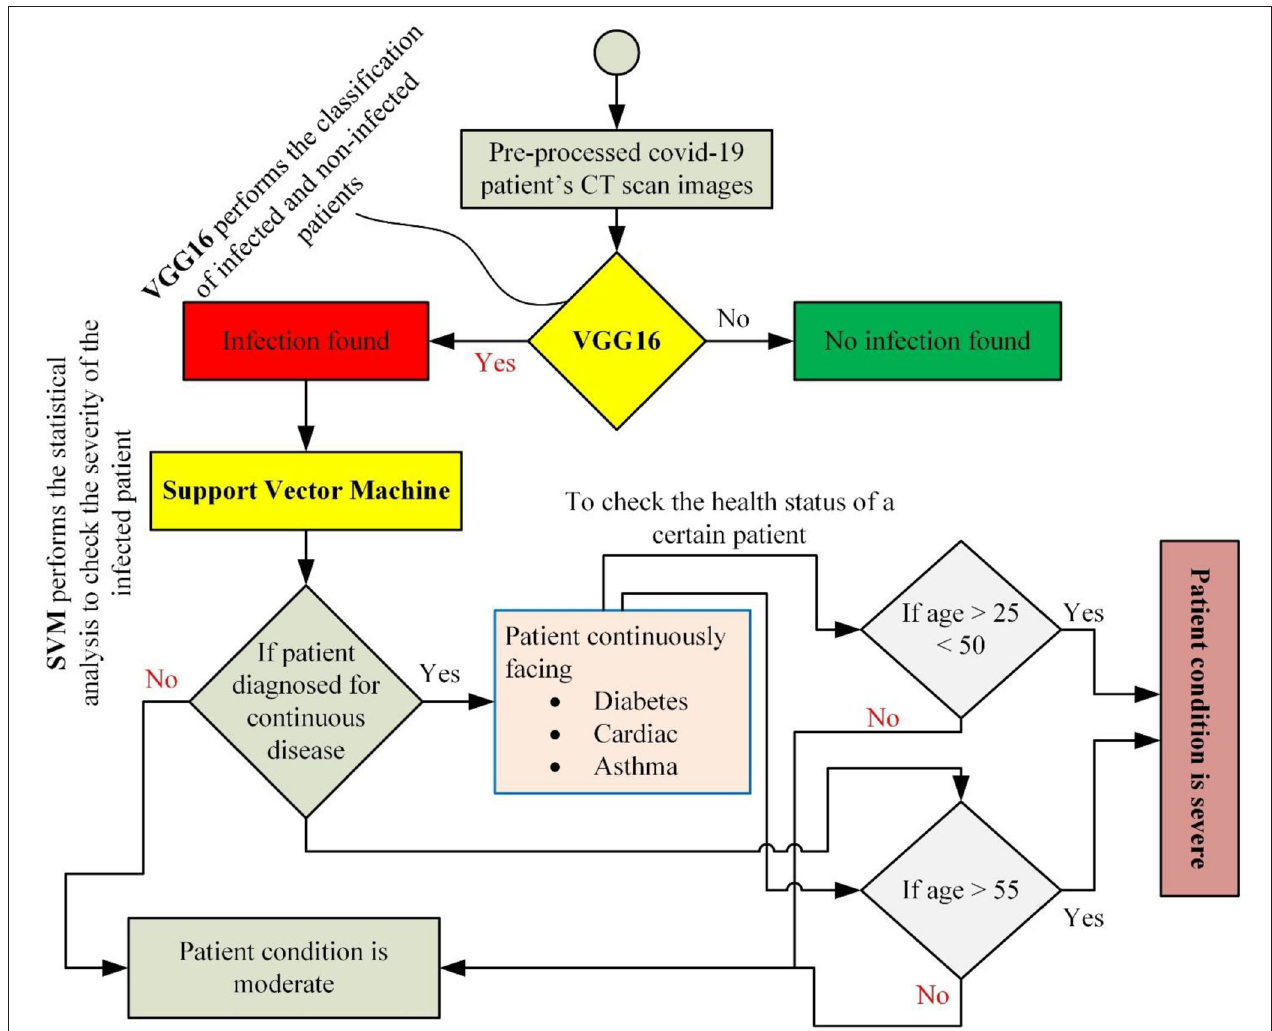
FIGURE 2 | A stepwise solution was followed to implement the proposed hybrid diagnosing model.